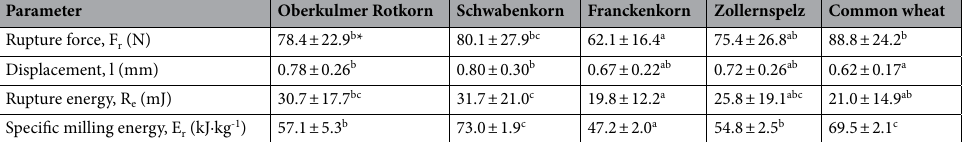
Table 3. Mechanical properties and specific milling energy of spelt and common wheat grain. *Values given as the average values ± standard deviation (SD). Values marked with the same letters in rows are not significantly different at p ≤